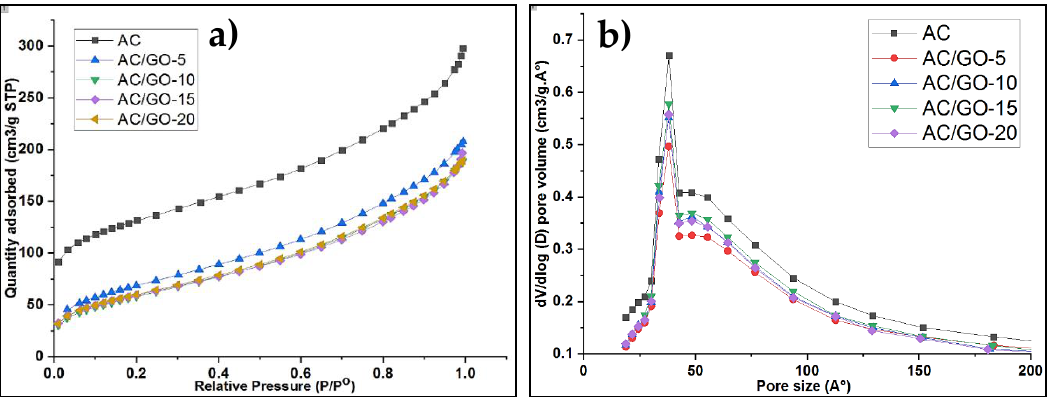
Figure 5. Nitrogen adsorption-desorption isotherm of ( a ) AC and AC/GO-x ( b ) Pore width distribution of AC and AC/GO-x.